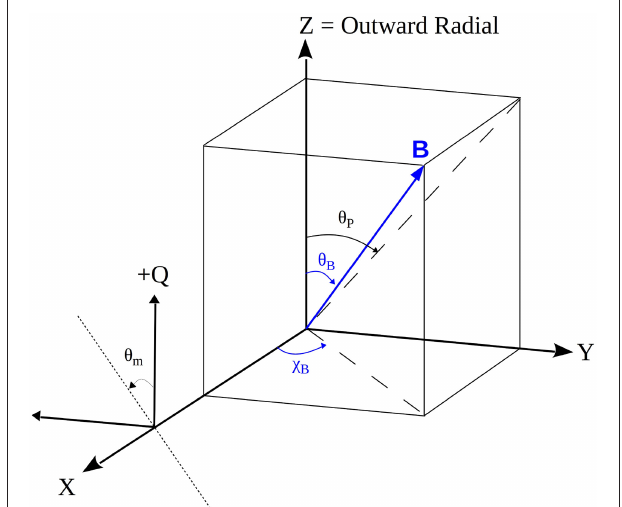
FIGURE 1 | Observing geometry for a magnetic field located in the plane of the sky (corresponding to the ZY plane). The + Z direction indicates the local outward radial direction so moving around the solar limb corresponds to a rotation about the X axis which is taken to coincide with the line of sight. The projected angle of magnetic field on the plane sky θ P is measured clockwise, while the angle of polarization θ m is measured counter-clockwise adhering to the common polarimetric convention. The reference direction for the polarization measurement is oriented along the outward radial